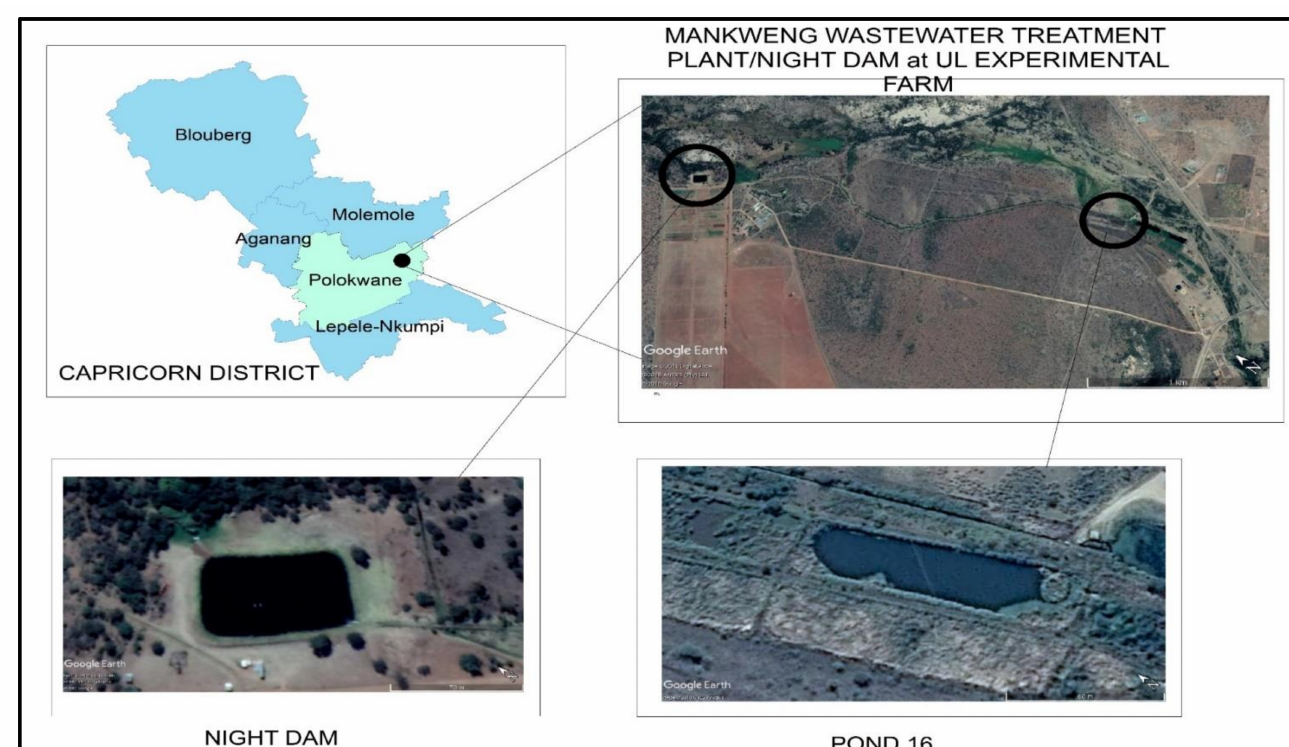
Figure 1. Study site, a pathway from pond 16 of MWTP to ULEF night dam along a 2.9 km canal.